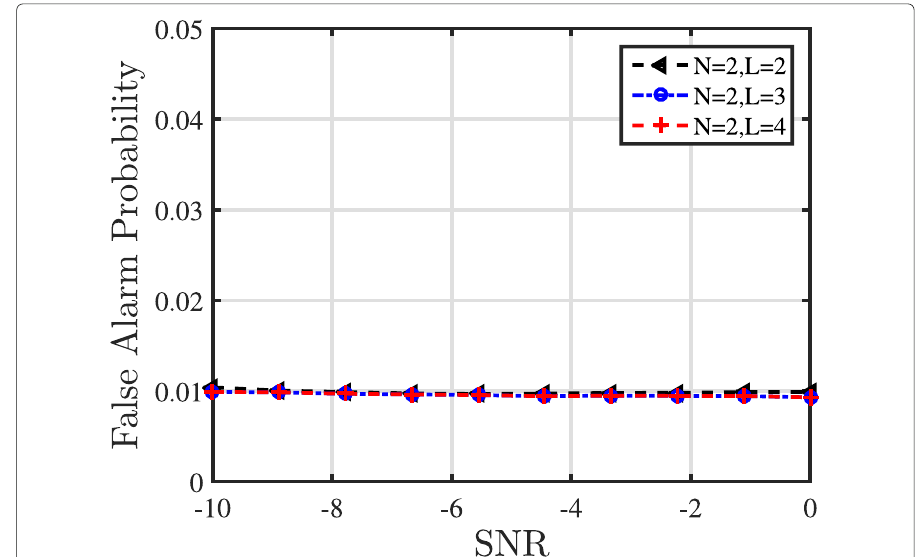
Fig. 3 False alarm probability of the GWT classifier for different number of channel taps, N = 2 and D =